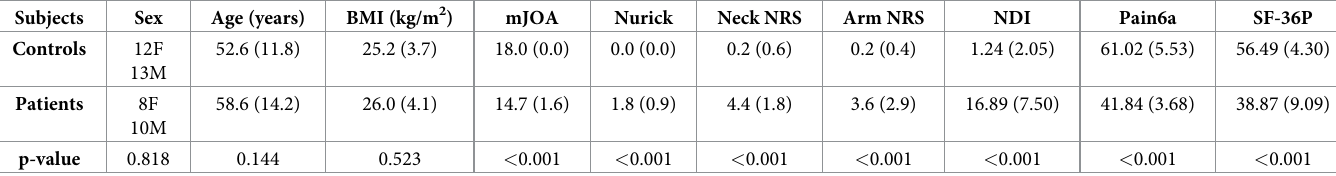
BMI = Body Mass Index, mJOA = modified Japanese Orthopedic Association, NRS = Numerical Rating Scale, Pain6a = Pain Interference Scale, NDI = Neck Disability Index, SF-36P = Health and well-being survey (physical component score). Mean (SD) and p-value are